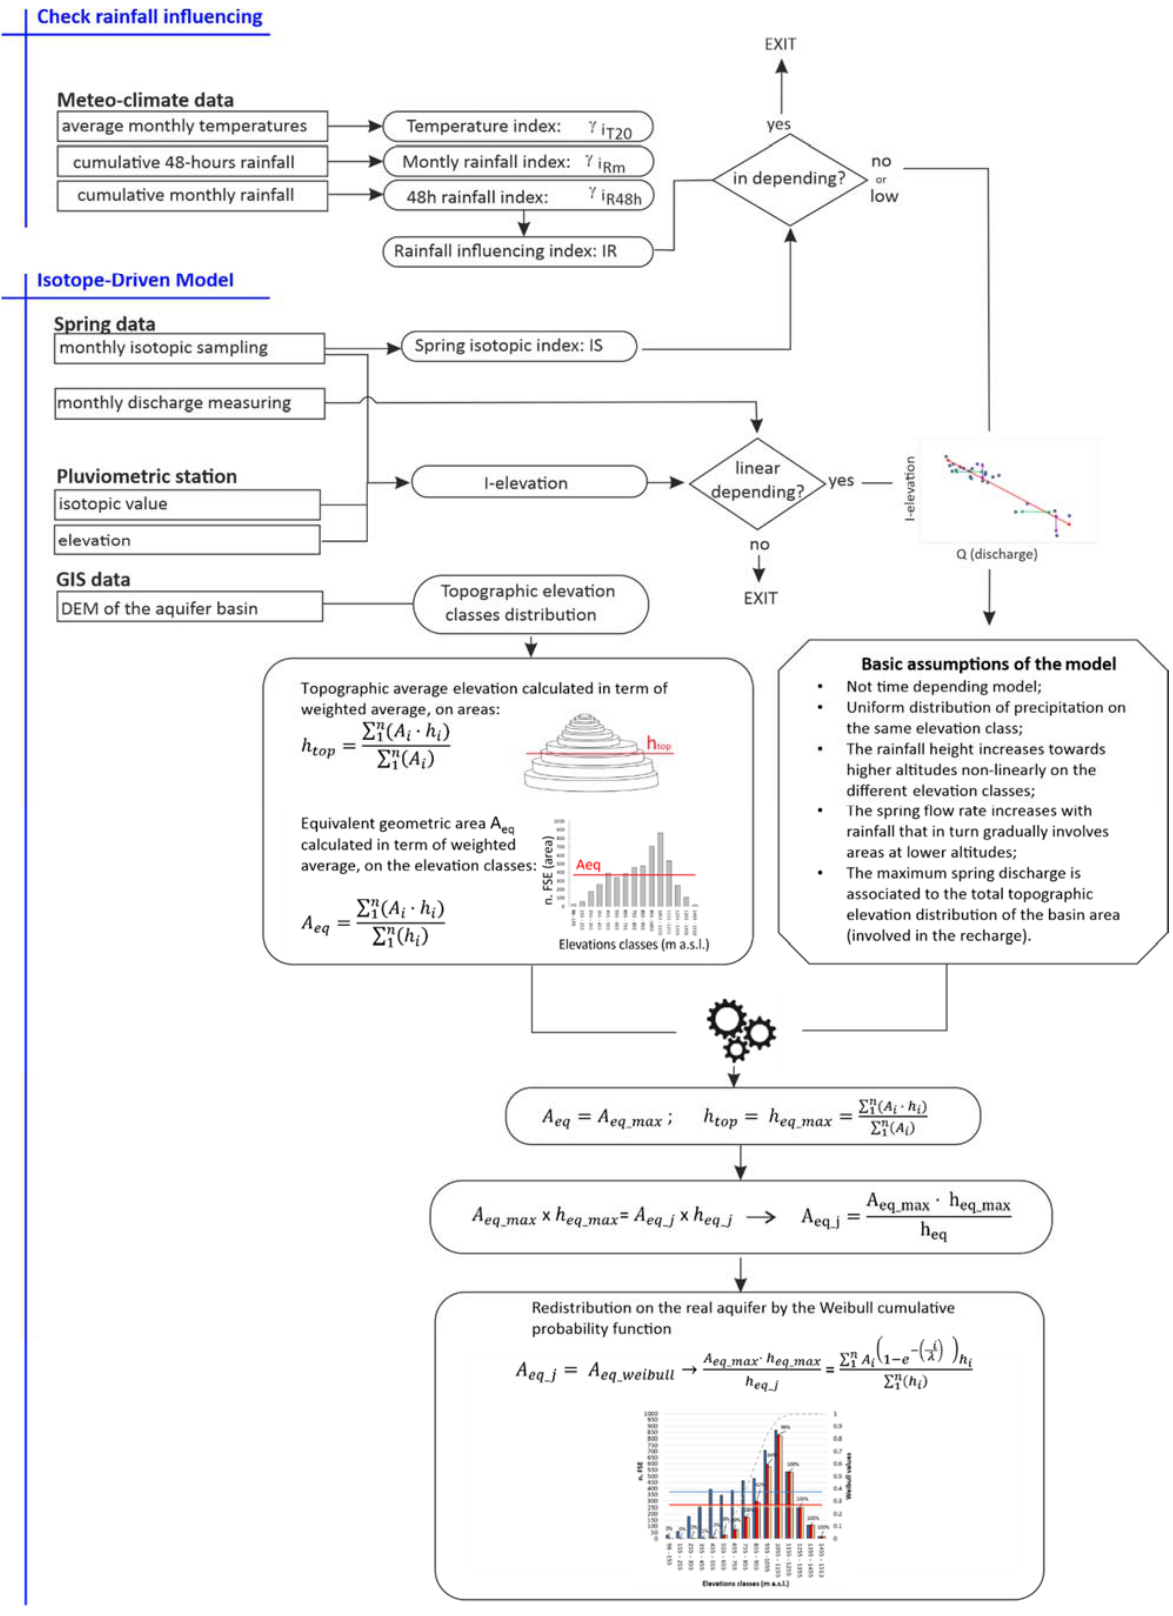
Figure 7. Flowchart of the proposed procedure for the recharge area estimation.